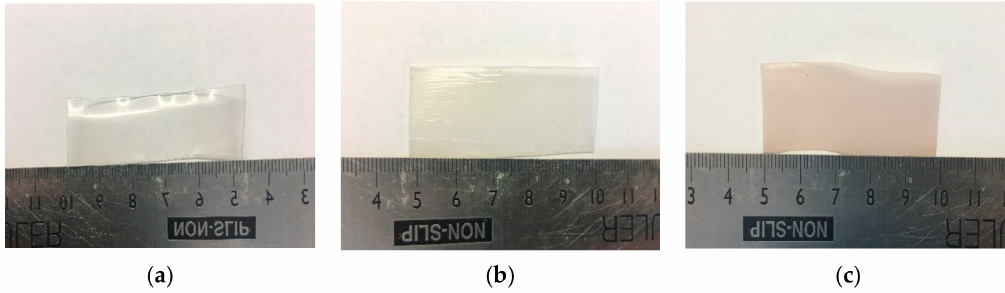
Figure 4. Photographs showing ( a ) virgin PLA films are transparent, ( b ) PLA / HNT nanocomposite films are opaque, ( c ) ASP-loaded PLA / HNT nanocomposite are mild pink in colour.